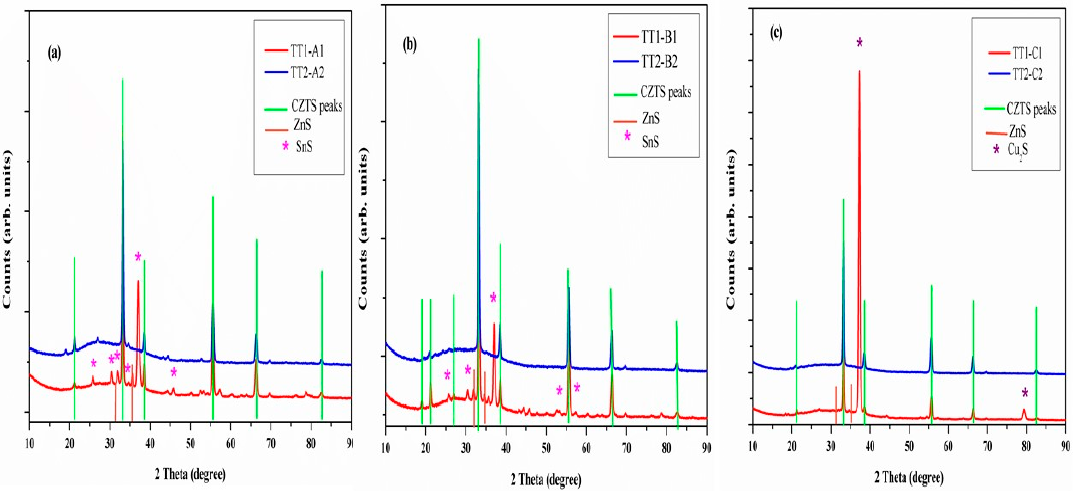
Figure 2. XRD pattern of CZTS samples at different thermal treatments: ( a ) TT1-A1, TT2-A2 ( b ) TT1-B1, TT2-B2 and ( c ) TT1-C1, TT2-C2.